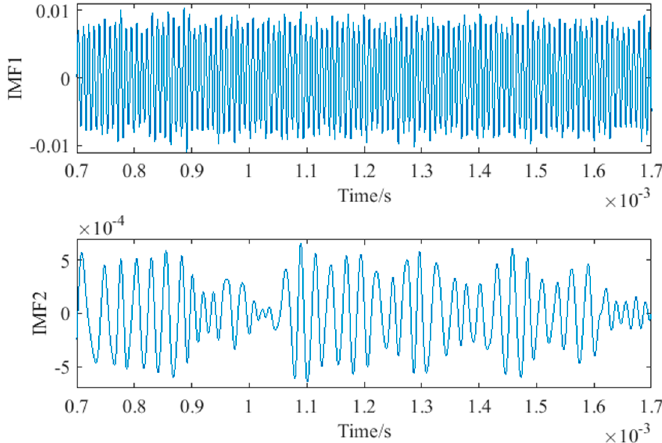
Figure 10. The local details of IMF1 and IMF2 components of the no damage signal after EMD.